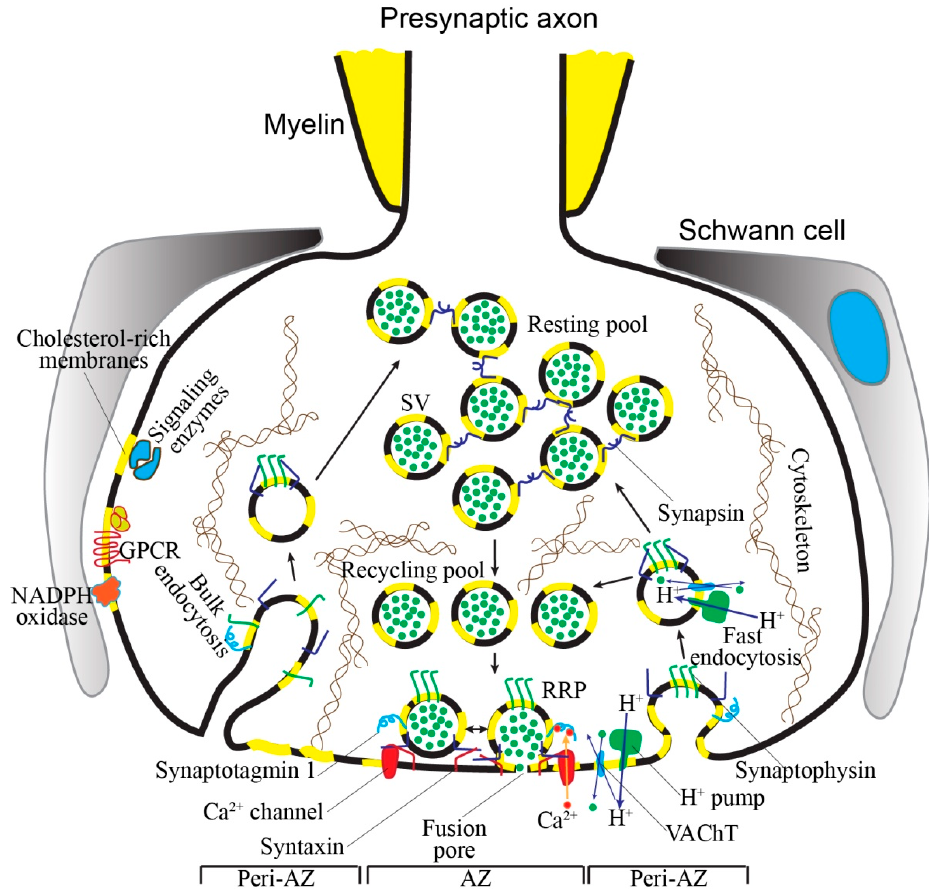
Figure 1. Putative role of cholesterol in presynaptic processes. Cholesterol organizes microdomains in presynaptic membrane and SVs. Several proteins, essential for presynaptic function, reside in these microdomains, and/or directly bind with cholesterol. These interactions are involved in control of multiple aspects of SV cycle that guarantees the maintenance of neurotransmitter release. Additionally, numerous presynaptic G-protein coupled receptors (GPCRs) and signaling enzymes (e.g., protein kinases and small GTPases), as well as a ROS-generating enzyme (NADPH oxidase), which regulates the steps of the SV cycle, could be located in cholesterol-rich microdomains. SV exocytosis occurs due to fusion of SVs from ready-releasable pool (RRP) with presynaptic membrane in AZ region. Under condition of moderate motor nerve activity, replenishment of RRP is mediated by delivery of SVs from recycling pool. After exocytosis, these SVs are able to rapidly recover through fast endocytotic mechanism, refill with ACh (green circles), and repeatedly participate in neurotransmitter release. Intense activation of motor neuron can led to mobilization of SVs from resting (reserve) pool to the exocytotic sites. After massive exocytosis, the resting pool is replenished by mainly slow endocytotic route (bulk endocytosis) associated with formation of endosome-like structures in NMJs. The cytoskeleton can contribute to spatial organization of both SV pools and routes for SV traffic. Key events, where the presence of cholesterol is required, are SV exocytosis (fusion pore formation, Ca 2+ triggering step), endocytosis (vesicular protein holding in cluster), SV refilling with ACh (formation of proton gradient, exchange ACh and proton), SV clusterization (SV interconnections by synapsins), limitation of ACh leakage via spontaneous (clamping of signaling enzymes activity and ROS production), and nonquantal (decrease in activity of vesicular ACh transporter and H + -pump in presynaptic membrane) secretion. Please, for details, see Sections 3 and 5.